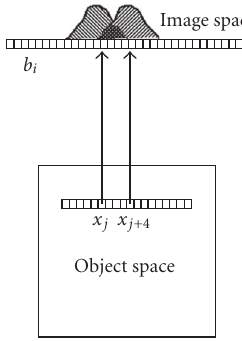
Figure 1: Overlapping between two close voxels’ PSF. The darkest zone will be used to reconstruct voxel x j as well as x j +4 (and all those in between), thus leading to a smoothed reconstruction after only a few